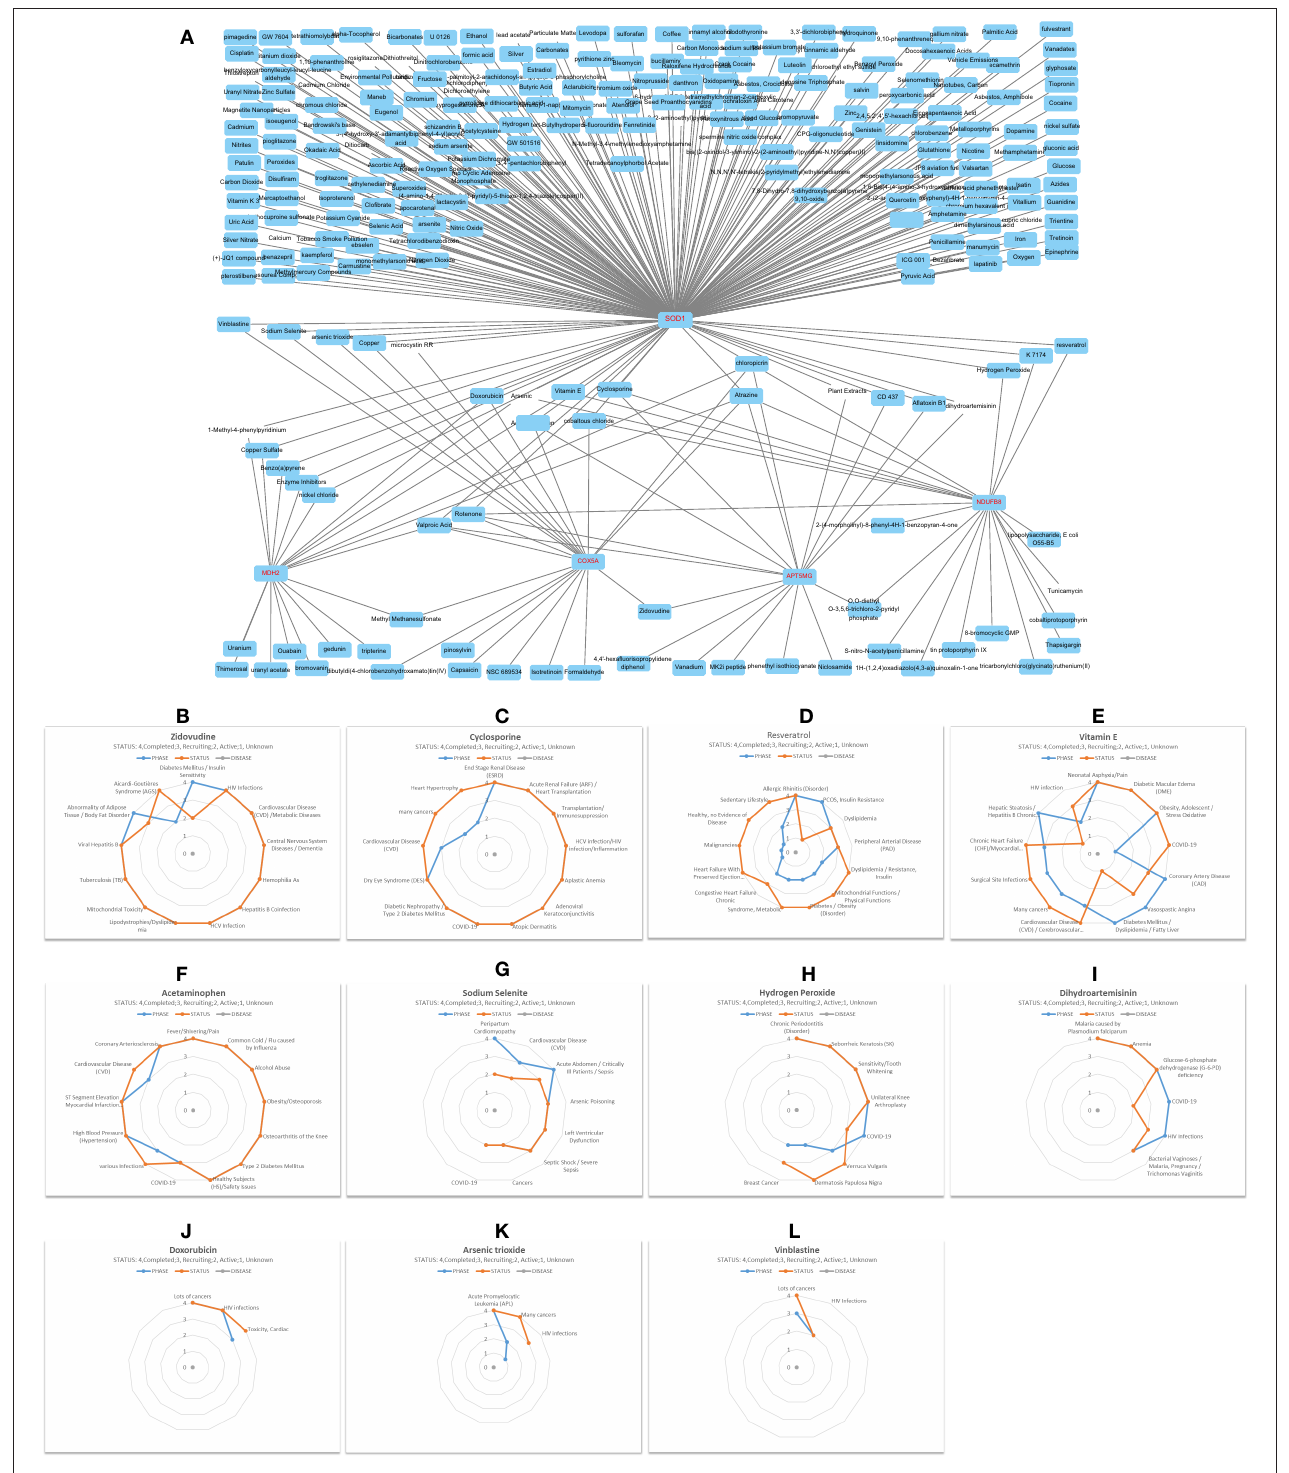
FIGURE 7 | Decipher chemicals (drugs) targeted critical network genes. (A) Mine 251 chemicals targeted the five coding genes in the ATP5MG-related network. (B) Clinical trials of Zidovudine. (C) Clinical trials of Cyclosporine. (D) Clinical trials of Resveratrol. (E) Clinical trials of Vitamin E. (F) Clinical trials of Acetaminophen. (G) Clinical trials of Sodium selenite. (H) Clinical trials of Hydrogen peroxide. (I) Clinical trials of Dihydroartemisinin. (J) Clinical trials of Doxorubicin. (K) Clinical trials of Arsenic trioxide. (L) Clinical trials of Vinblastine.